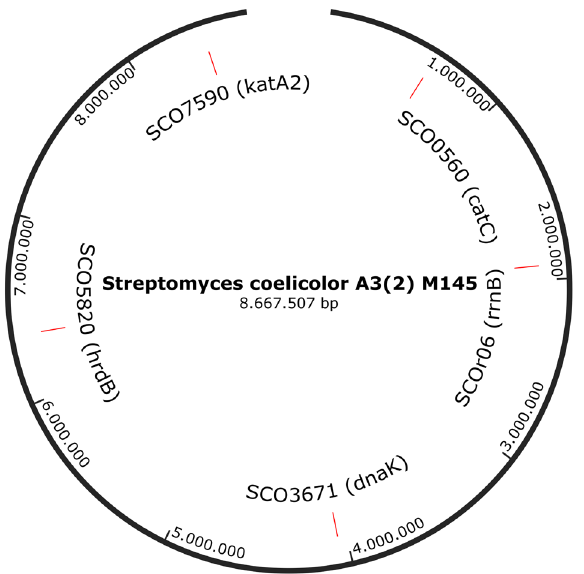
Figure 2. Map of S. coelicolor A3(2) M145 chromosome. Positions of katA2 , catC , dnaK , hrdB , and rrnB are reported. The map was prepared with the software SnapGene Viewer using the sequence of S. coelicolor A3(2) available in GenBank with accession number